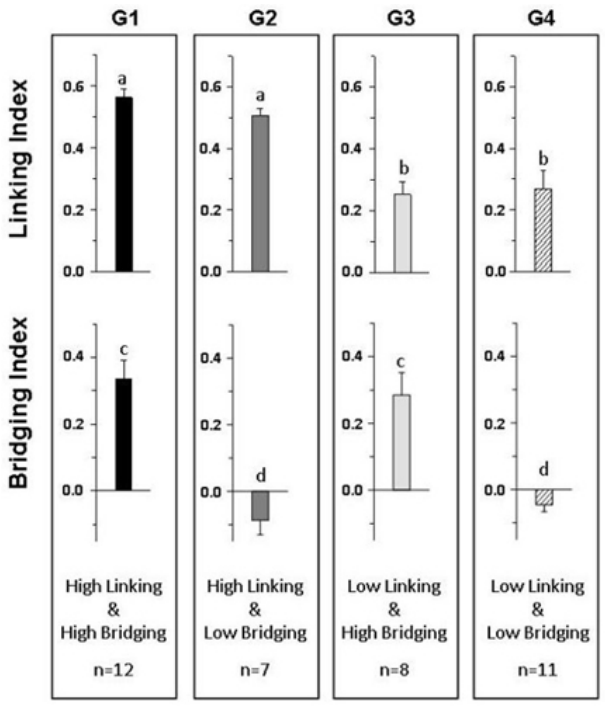
Fig. 3 . Fisher organizations’ social capital groups based on linking and bridging indices. Significant differences are represented by different superscript letters and analyzed with one-way ANOVA and Dunn’s posteriori tests (for Bridging Index groups F = 19.275 and P < 0.001; for Linking Index groups F = 14.338 and P <